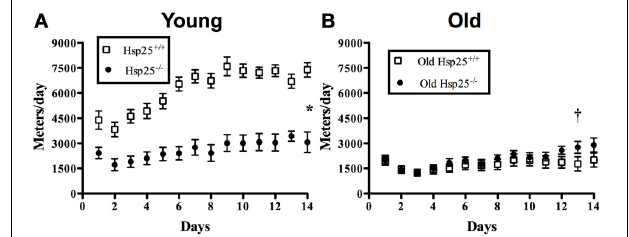
FIGURE 1 | Average daily running wheel distance in young (A) and old (B) Hsp 25 + / + and Hsp 25 − / − mice. Total area under the curve was calculated over 14 days and compared among groups. *Significantly different from young Hsp 25 + / + ( P < 0 . 0001), † significant main effect of age ( P < 0 . 0001). Data are presented as means ± SE, n = 10 for young groups and n = 12 for old groups.